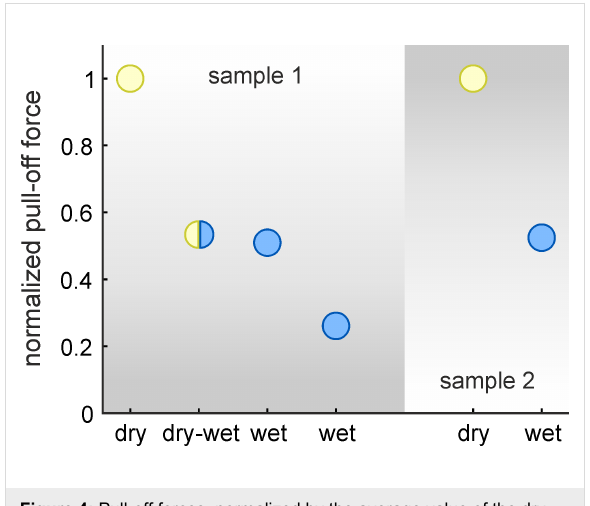
Figure 4: Pull-off forces, normalized by the average value of the dry state. Two individual MSAMS samples were measured on glass substrates for different wetting conditions: dry state (yellow circle), dry–wet state (yellow/blue circle), and wet state (blue circles). Dry state corresponds to measurements under ambient conditions. Dry–wet state corresponds to measurements where the sample has been brought into contact under dry conditions, but subsequently submerged in water. Wet state corresponds to measurements where the sample has been brought into contact when already submerged. For sample 1 the median dry state pull-off force was ca. 570 µN ( N = 5, min. value ca. 540 µN, and max. value ca. 590 µN). For sample 2 the median dry state pull-off force was ca. 490 µN ( N = 5, min. value ca. 440 µN, and max. value ca. 570